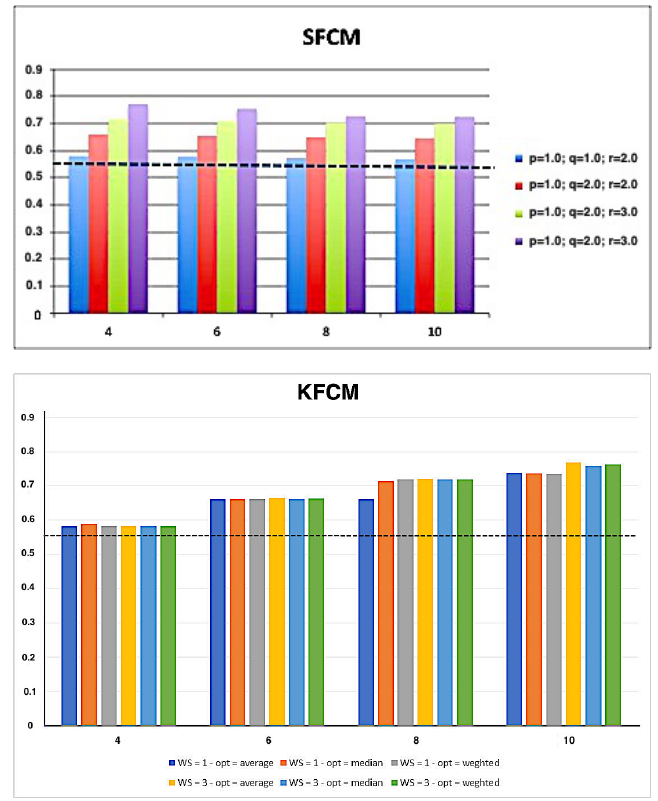
Figure 4. Average trend of the entropy-based measure. The dotted line refers to the average value computed on the ground truth segmented images.